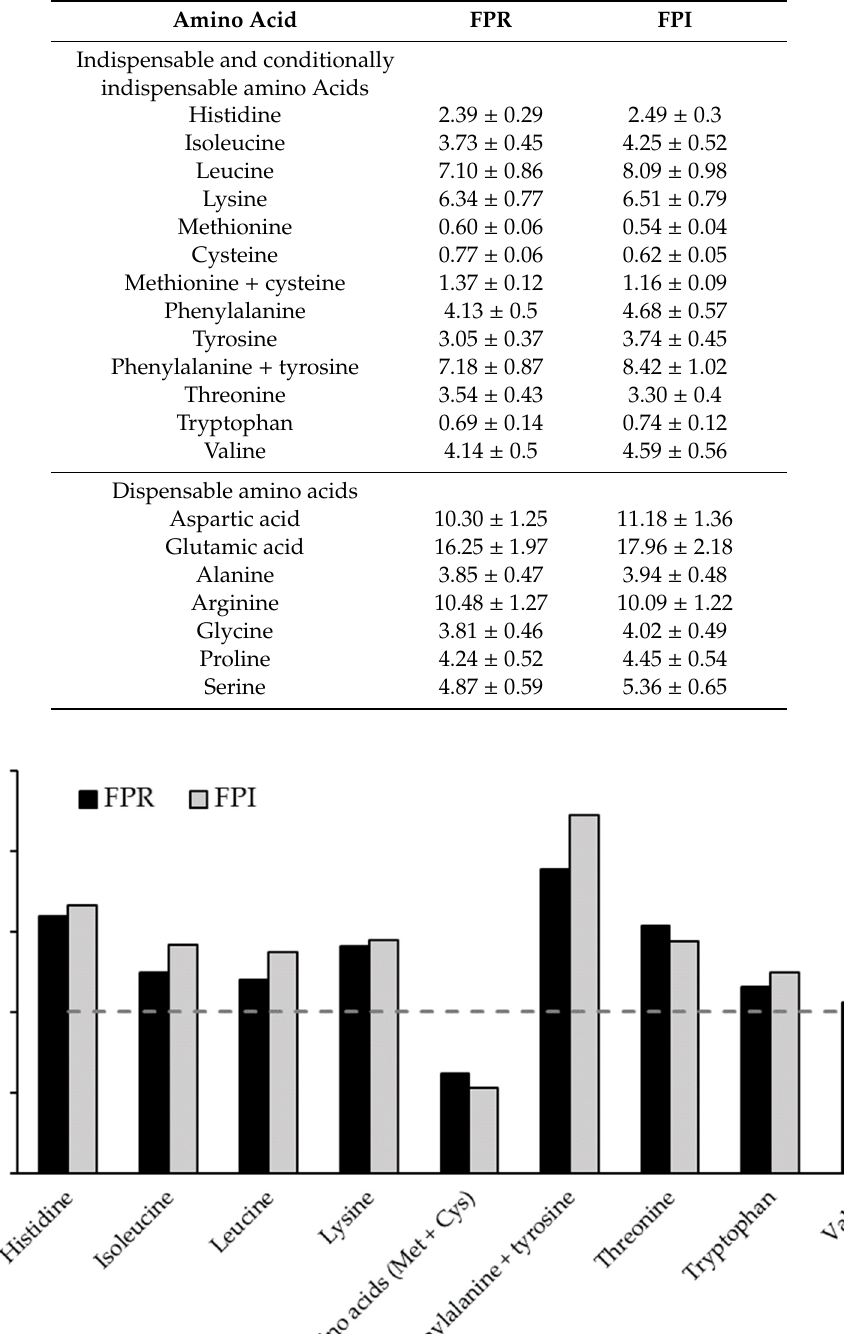
Table 4. Amino acid profiles for FPR and FPI. Results are expressed as g / 100 g protein (N × 6.25).